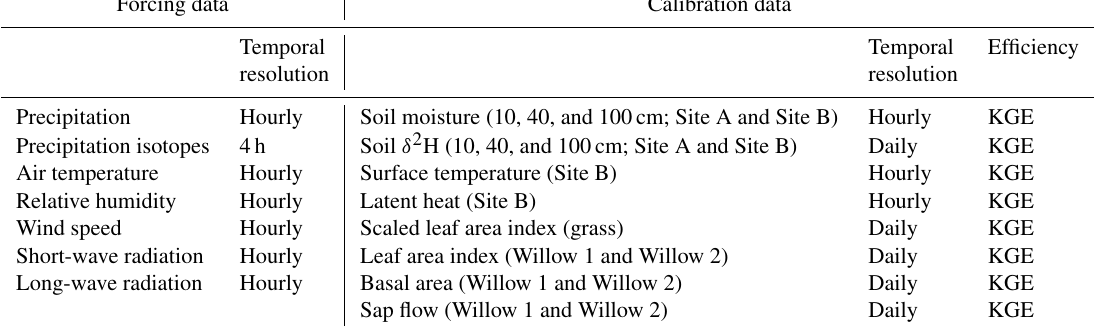
Table 2. Forcing and calibration data of EcH 2 O-iso calibration. Round brackets in the calibration datasets indicate the spatial locations of all available measured data.